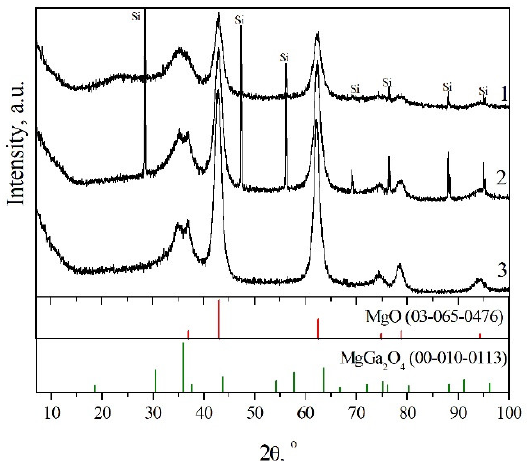
Figure 5. XRD patterns of calcined MgGa LDHs (T = 550 °C) with different mole fraction of Mg 2+ (1—0.67; 2—0.75; 3—0.80).